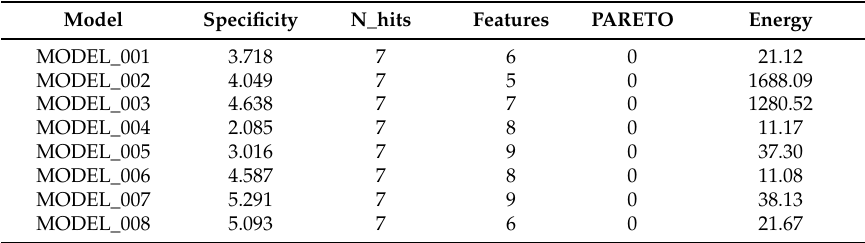
Table 1. The validation results of each GALAHAD model for CDK2 allosteric